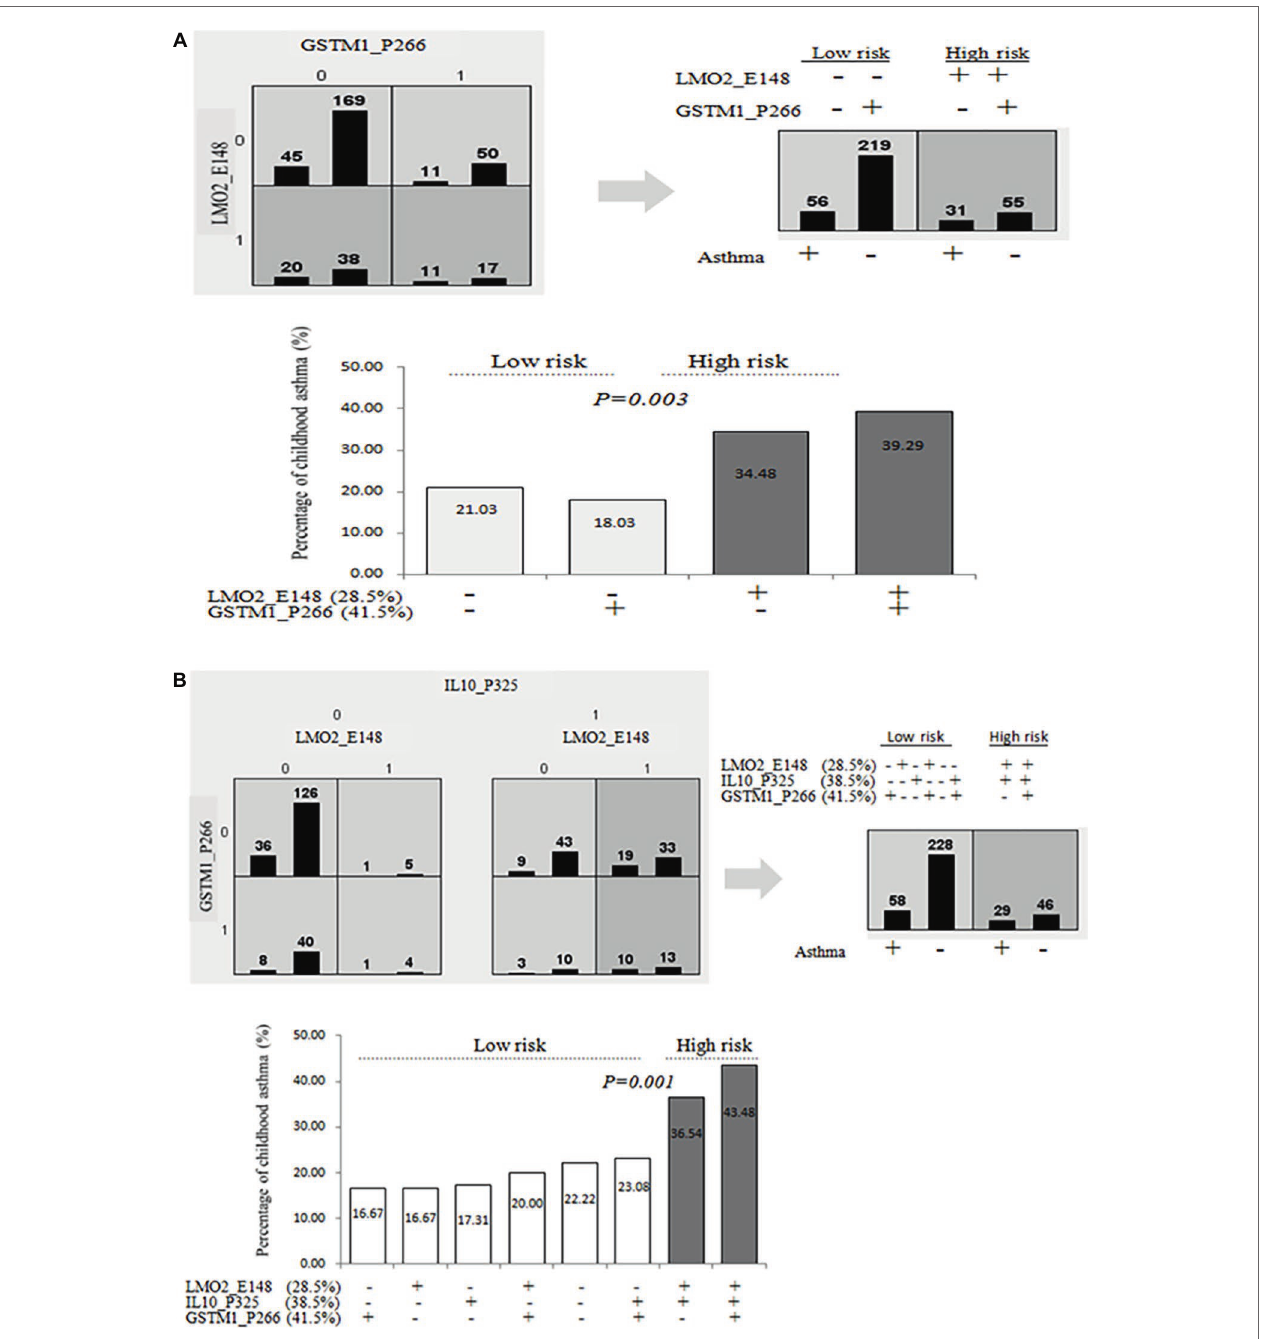
FIGURE 3 | Prediction of asthma by combined higher methylation contents of LMO2_P794, LMO2_E148, GSTM1_P266 or/and IL10_P325 CG sites. (A) Prediction of higher or lower LMO2_E148, IL10_P325 , and GSTM1_P266 CG methylation levels (based on ROC curve) for childhood asthma determined by MDR analyses in two-way mode; (B) prediction of higher LMO2_E148, IL10_P325 , and GSTM1_P266 CG methylation levels (based on ROC curve) for childhood asthma determined by MDR analyses in three-way